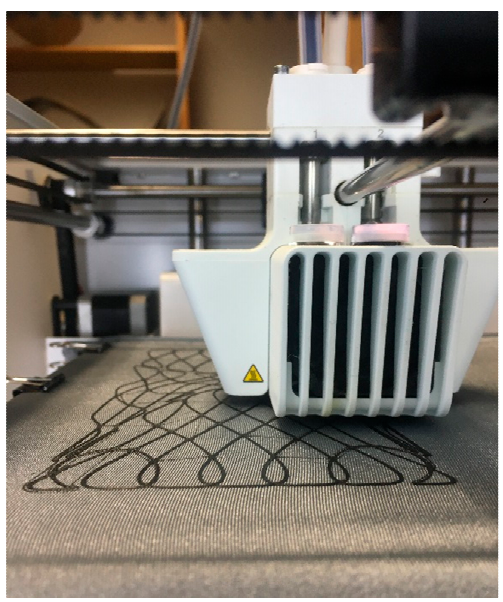
Figure 4. Three-dimensional (3D) printing onto the textile.